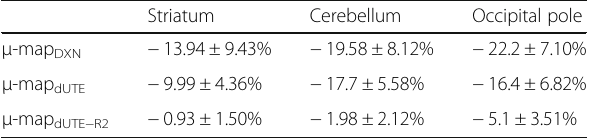
Table 2 Mean E n (%) and mean standard deviation in PET activity concentration across subjects averaged over time (8 – 70